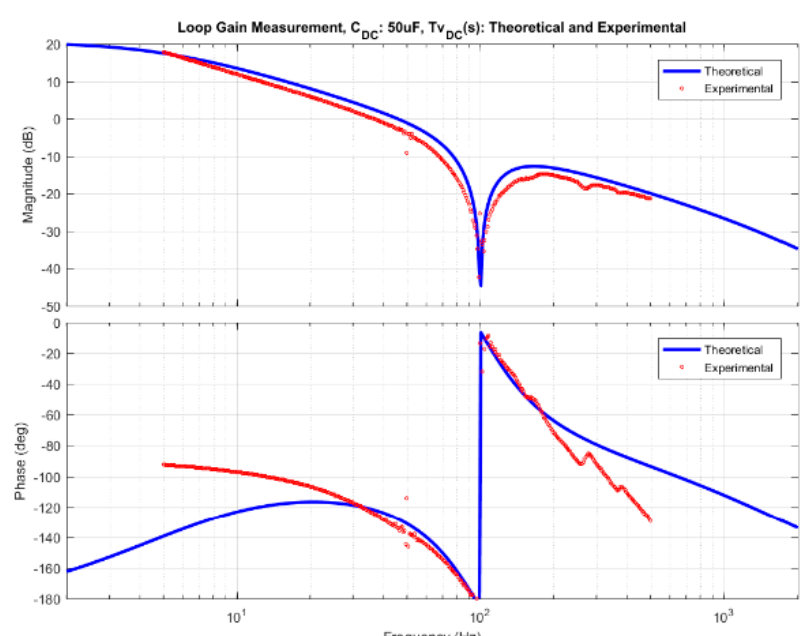
Figure 16. Loop gain frequency response of Tv DC (s). P G = 230 W, C DC = 50 µF. Blue: theoretical, red: experimental.